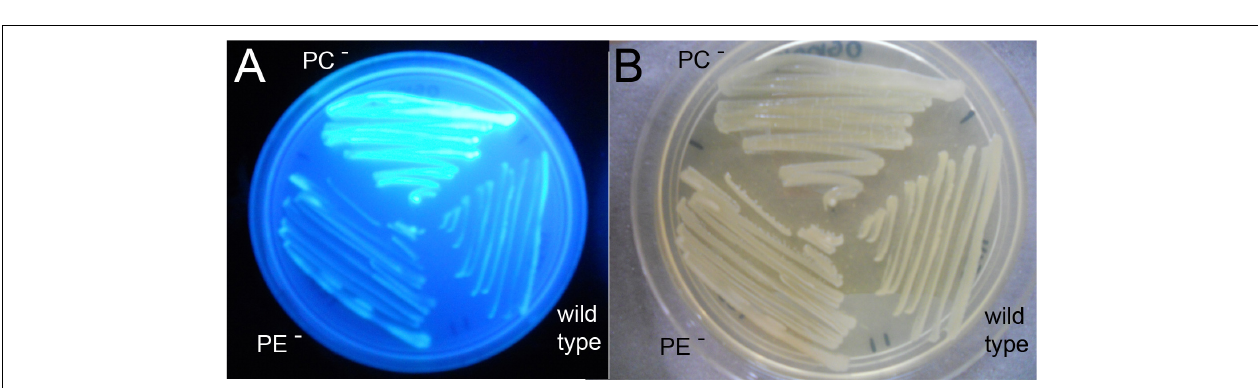
FIGURE 5 | Swimming motility of Sinorhizobium meliloti 1021 strains. The assay was performed at 28 ◦ C on LB/MC + -containing swim plates (0.3% agar) and analyzed after 2 days. (A) S. meliloti 1021 (wild type), PC-deficient mutant OG10017, PE-deficient mutant CS111. (B) S. meliloti 1021 (wild type), PC-deficient mutant OG10017, OG10017 complemented with pmtA -expressing plasmid pTB2042, OG10017 complemented with pcs -expressing plasmid pTB2532, and OG10017 harboring the empty broad host range plasmid pRK404.